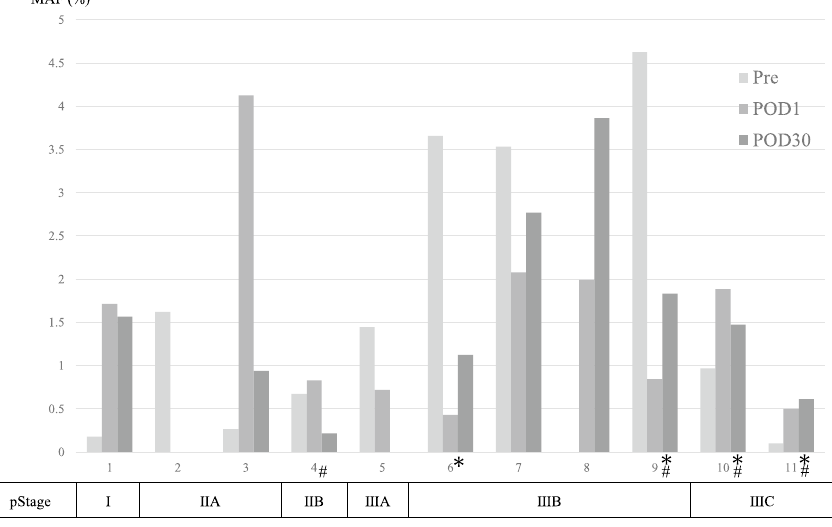
Figure 2. The mutant allele frequencies of BRAF V600E mutation in all cases. Perioperative changes in MAF were not related to the time course. The amounts of POD1 and POD7 in Case 2, POD30 in Case 5, and preoperative BRAF V600E in Case 8 were small and undetectable. The pStage is presented as described in the TNM 8 version. # Recurrence; *Adjuvant chemotherapy; Pre, preoperative; POD, postoperative day.